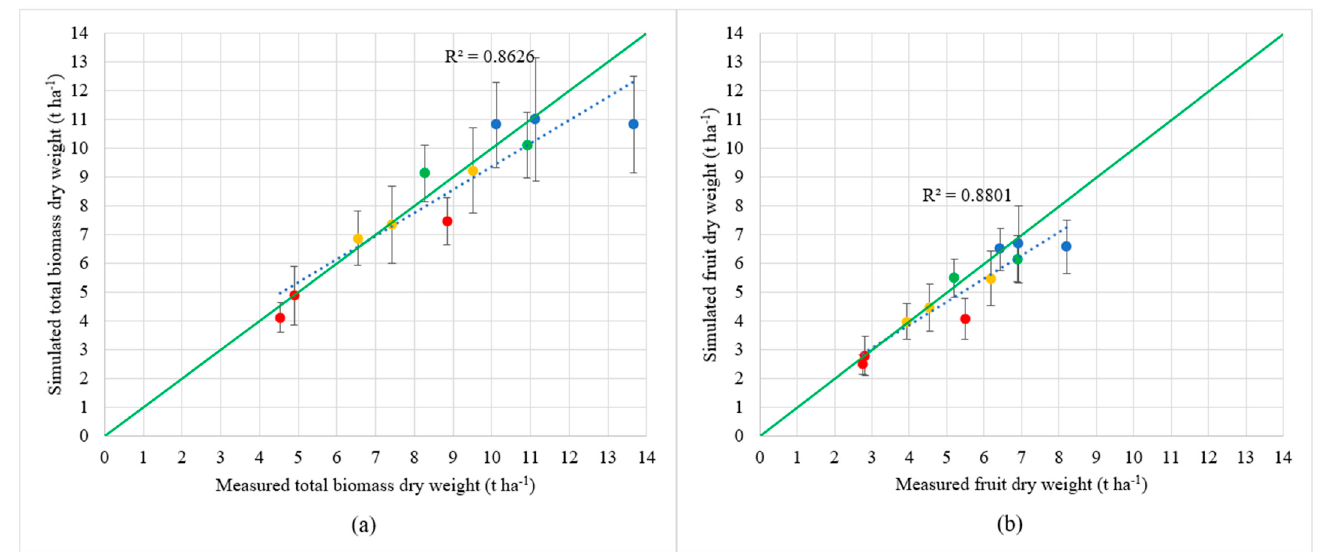
Figure 5. Simulated and measured values at harvest for ( a ) biomass and ( b ) yield. Error bars represent the standard deviation. Solid green lines represents the perfect model, and the dotted line represents the fitted linear model (n = 11). Dot colors indicate: red (K), yellow (I50), green (I75), and blue (I100).